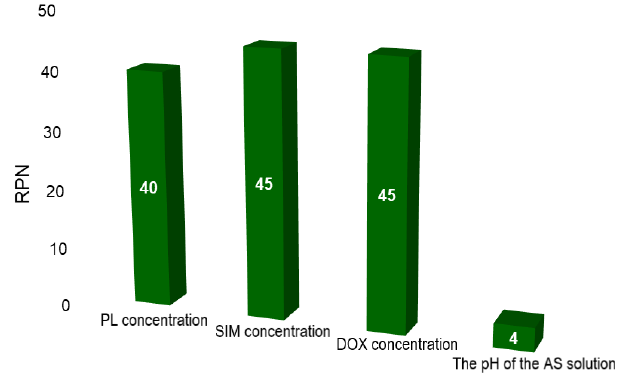
Figure 1. The RPN of each factor evaluated via